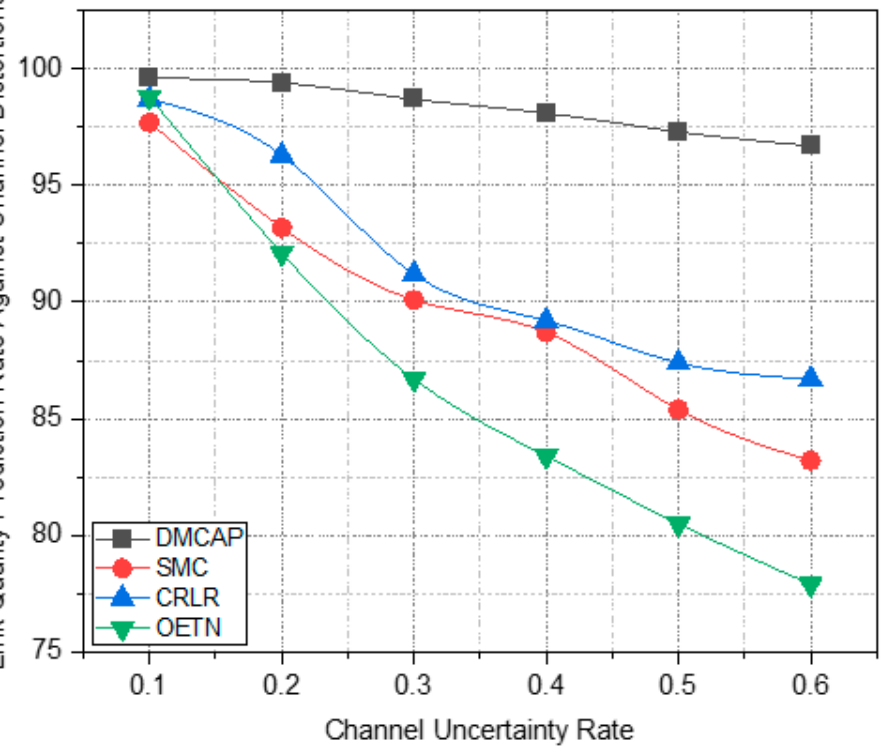
Figure 8. Link quality prediction rate against channel distortion.